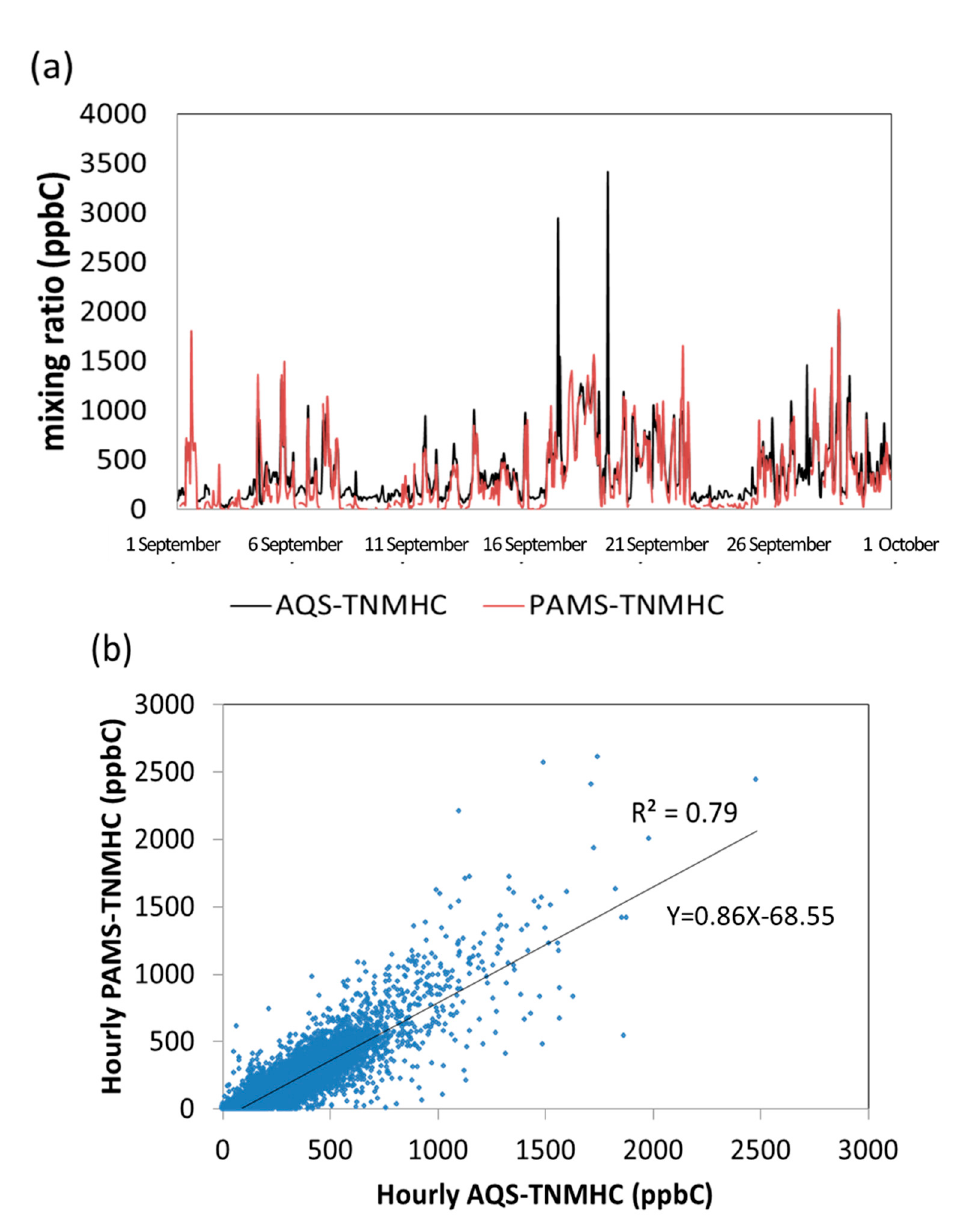
Figure 3. Mixing ratios (ppbC) of PAMS–TNMHC vs. those of AQS–TNMHC at site F1. ( a ) One–month continuous data in September 2014 to show high synchronicity; ( b ) scatter plot of a two–year dataset from October 2013 to September 2015 to show correlation.